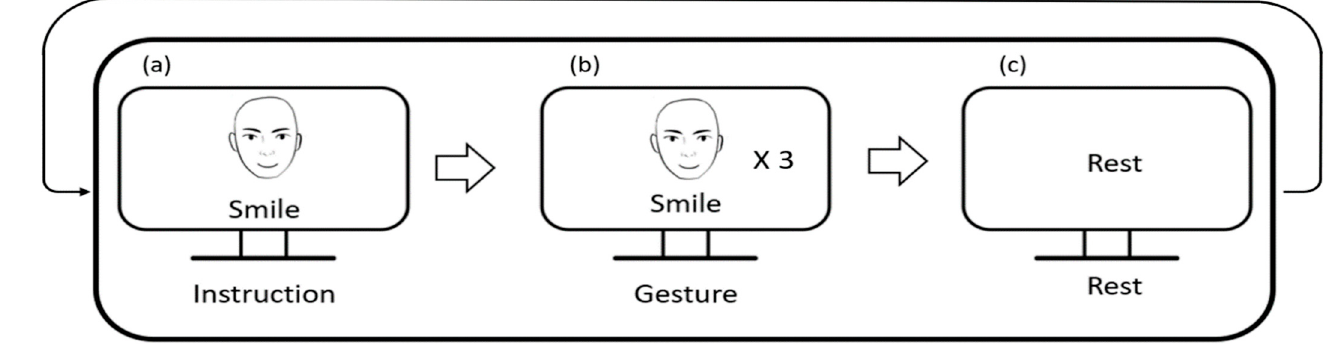
Table 1. List of predictable facial expressions.